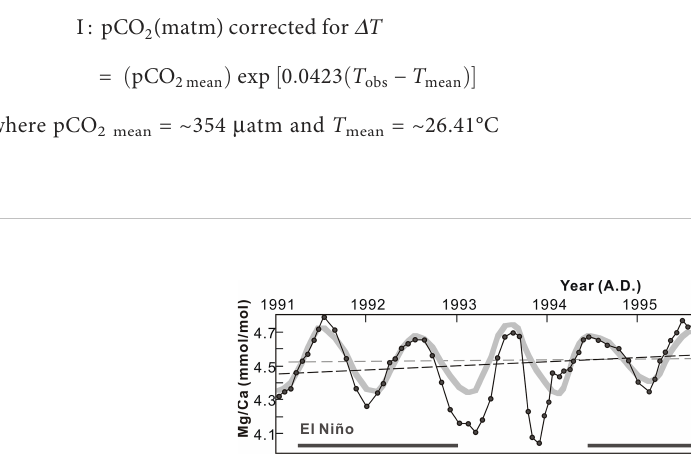
FIGURE 5 Comparison of Mg/Ca-SST record in the Lanyu corals and satellite